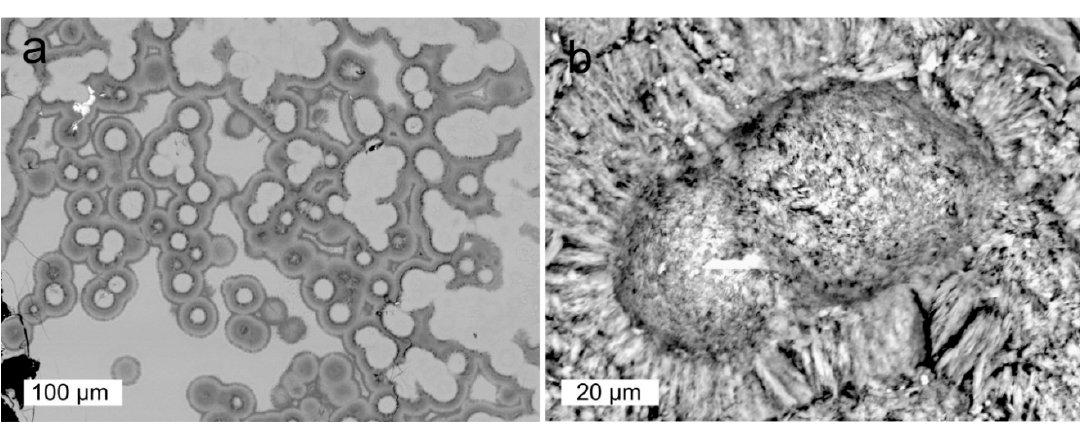
Figure 5. ( a ) SEM migrographs of spherical opal ‐ CT aggregates within a chalcedony matrix in an agate from El Picado, Cuba; ( b ) close ‐ up of ( a ) showing lepispheres of opal ‐ CT consisting of radially arranged crystal blades.